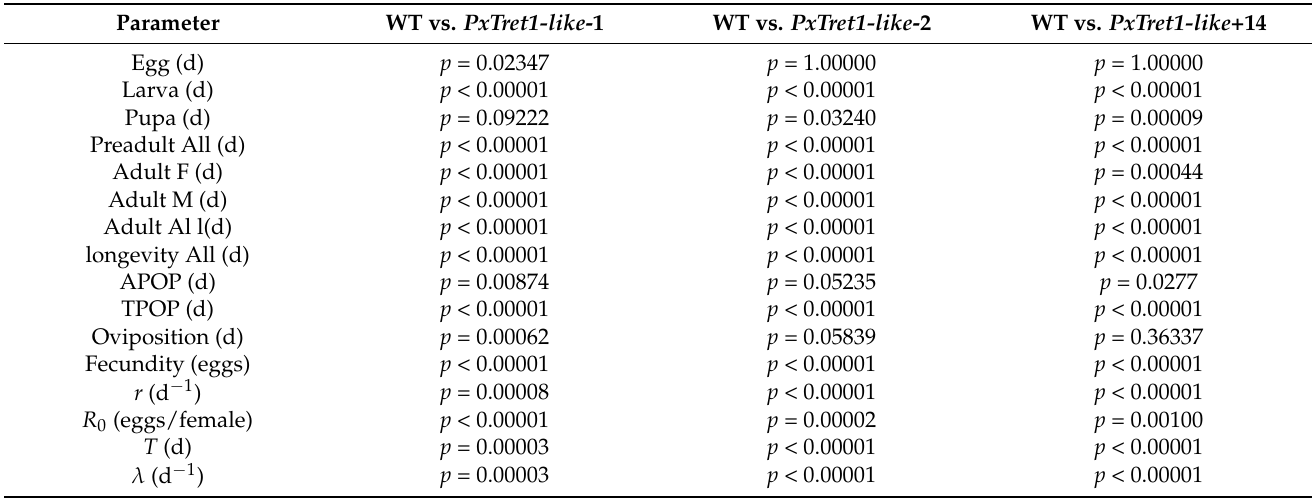
Table A1. Parameter difference of different PxTret1-like mutants and wild-type strain in different